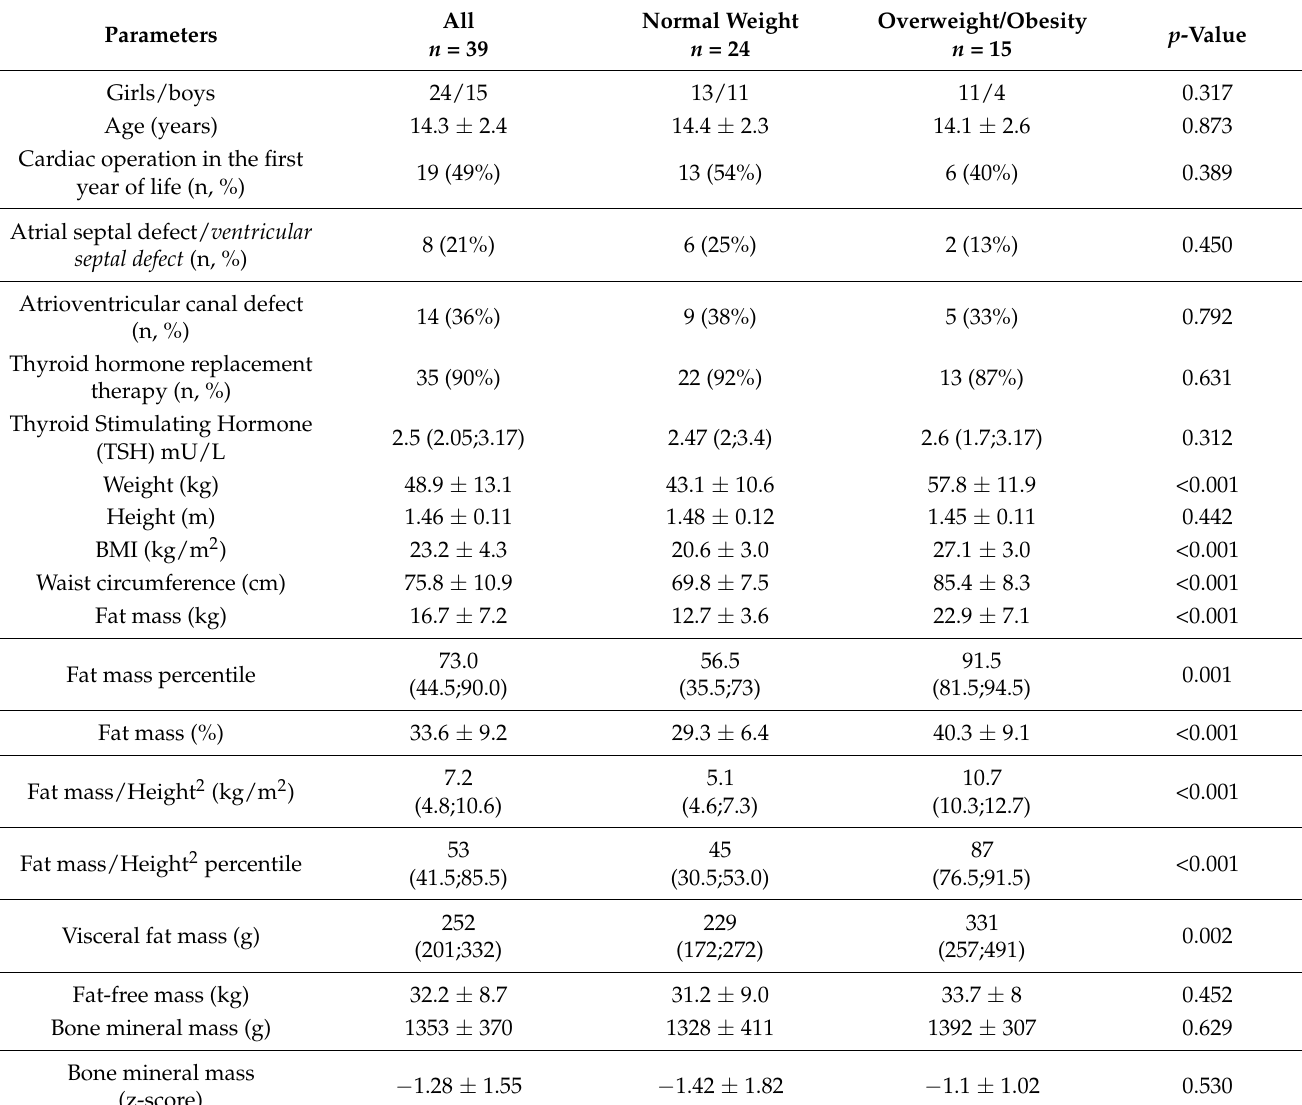
Table 1. Characteristics of study groups and comparative analysis of body composition and anthro- pometric measurements in DS children with normal and excess body